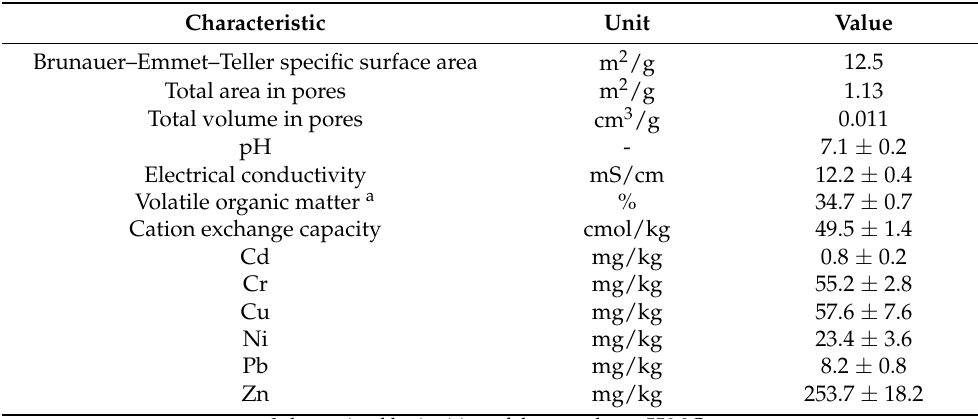
Table 2. Selected physical and chemical characteristics of municipal sewage sludge compost (MSSC) (n = 3, mean ± standard